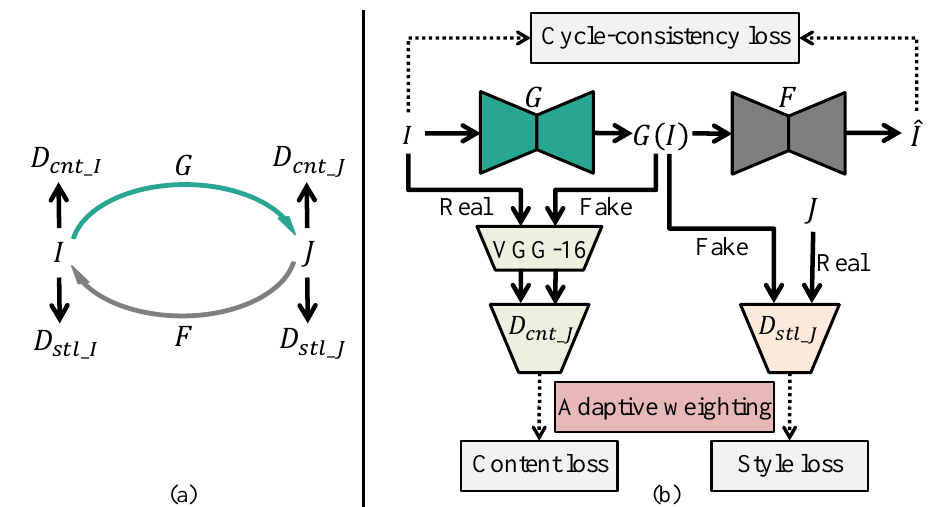
Figure 5. Framework of the proposed method. ( a ) Overall framework. ( b ) Unfolded framework for I → G ( I ) → F ( G ( I )) where dotted lines indicate